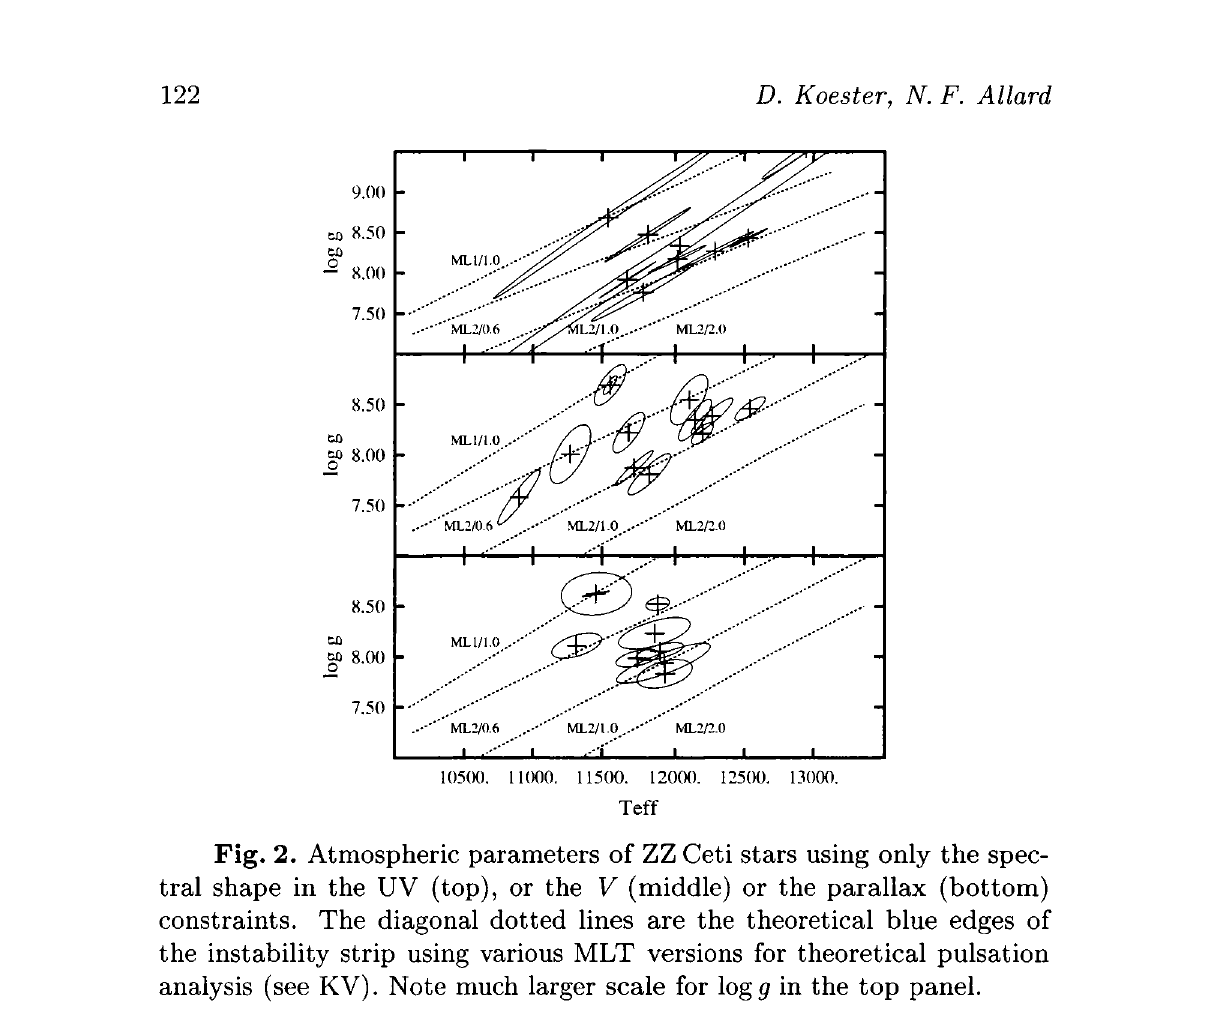
Fig. 2. Atmospheric parameters of ZZ Ceti stars using only the spec- tral shape in the UV (top), or the V (middle) or the parallax (bottom) constraints. The diagonal dotted lines are the theoretical blue edges of the instability strip using various MLT versions for theoretical pulsation analysis (see KV). Note much larger scale for log g in the top